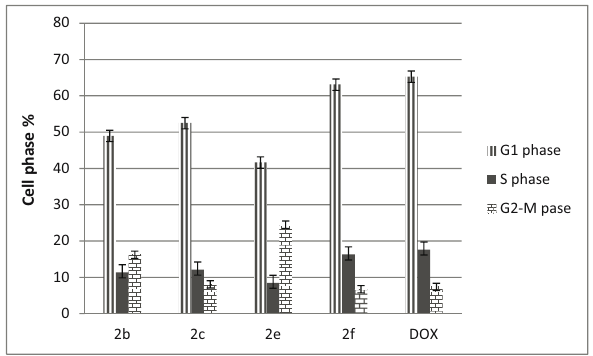
Figure 4: Cell cycle analysis of Hep3B cells after treatment with the synthesized compounds and DOX.